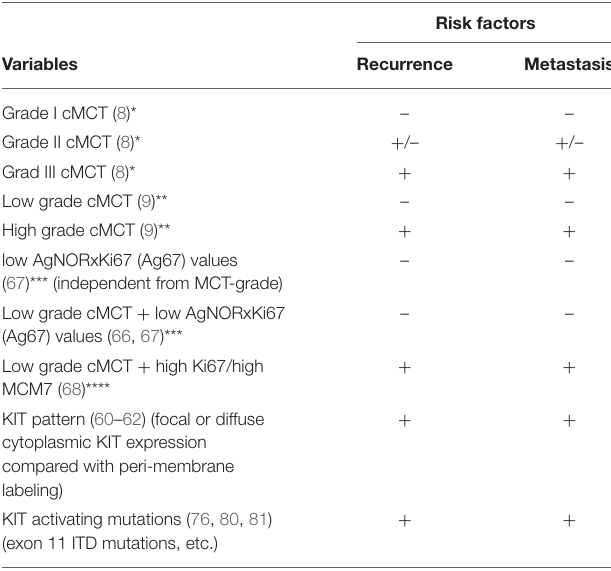
TABLE 3 | Risk assessment for local recurrence and systemic spread and/or metastasis of